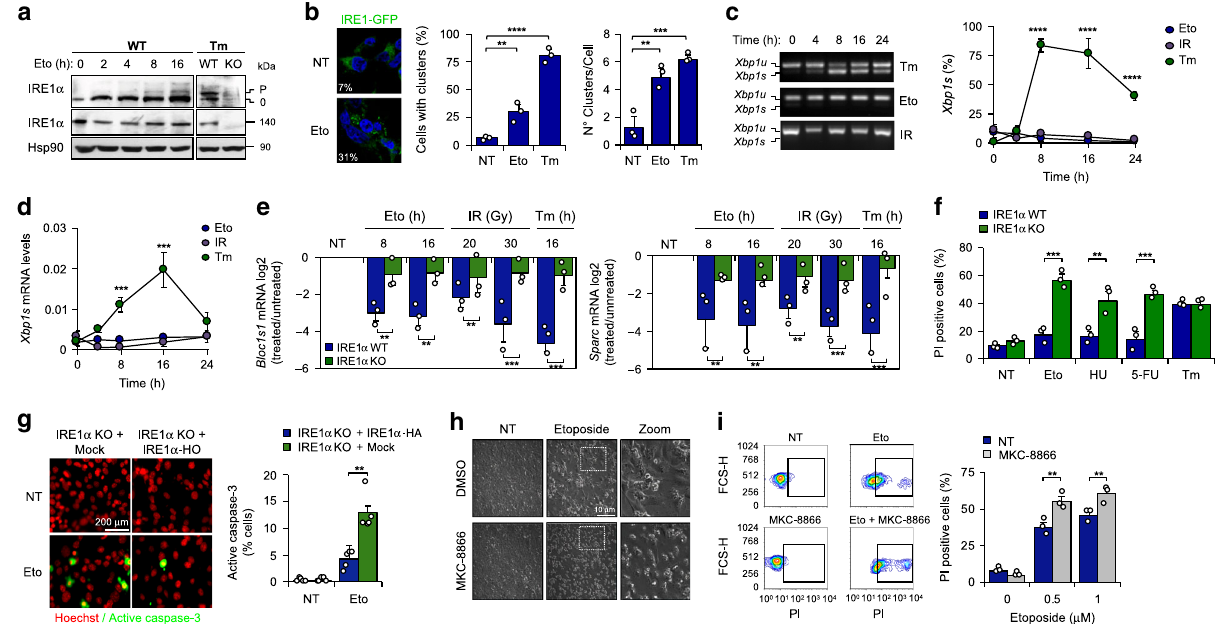
Fig. 1 Selective activation of RIDD under DNA damage. a MEF were treated with 10 μ M etoposide (Eto) for indicated time points and phosphorylation levels of IRE1 α were detected by Phostag assay (p: phosphorylated 0: non-phosphorylated bands). IRE1 α levels were analyzed by western blot. Treatment with 500 ng/mL tunicamicyn (Tm) as positive control (8 h) ( n = 3). b TREX-IRE1-3F6H-GFP cells were treated with 25 μ M Eto (8 h) or 1 μ g/mL Tm (4 h). IRE1-GFP foci were quanti fi ed by confocal microscopy (>200 cells, n = 3). c MEF were treated with either 100 ng/mL Tm, 10 μ M Eto or 25 G γ of ionizing radiation (IR) at indicated time points. Xbp1 mRNA splicing percentage was calculated by RT-PCR using densitometric analysis (left panel) ( n = 3). d Xbp1s mRNA levels were quanti fi ed by real-time-PCR in samples described in c ( n = 3). e WT and IRE1 α KO cells were treated with 10 μ M Eto (8 h and 16 h), IR (20 or 30 G γ , 16 h) and the decay of mRNA levels of Bloc1s1 and Sparc was monitored by real-time-PCR. Treatment with 500 ng/mL Tm as positive control ( n = 3). f WT and IRE1 α KO cells were treated with 25 μ M Eto, 1 μ M 5- fl uorouracil (5-FU), 1 μ M hydroxyurea (HU) or 1 μ g/mL Tm by 24 h and viability analyzed using propidium iodide (PI) staining and FACS ( n = 3). g IRE1 α KO (Mock) and IRE1 α -HA reconstituted cells were treated with 10 µ M Eto for 12 h and apoptosis monitored by caspase-3 positive cells (green). Nucleus (Red) was stained to visualize cells number ( n = 3). h MEF cells treated 36 h with 0.5 μ M Eto in combination with the IRE1 α inhibitor 25 μ M MKC-8866. Representative images. i WT cells were treated with 0.5 and 1 μ M Eto or in combination with 25 μ M MKC-8866 (36 h). Cell viability analyzed using PI staining and FACS ( n = 3). All panels data is shown as mean ± s.e.m.; * p < 0.05, ** p < 0.01, and *** p < 0.001, based on b two-tailed unpaired t -Student ’ s test, ( c , d ). One-way ANOVA followed Tukey ’ s test ( e – g , i ), two-way ANOVA followed Bonferroni ’ s test. Data is provided as a Source Data fi